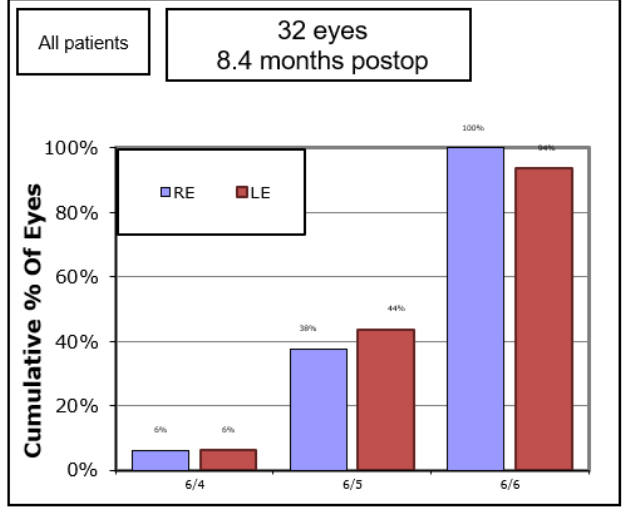
Figure 1. Percent of participants having a UCVA of at least 6/6, 6/5, and 6/4. Comparison between subgroups PRK (N = 13) and transepithelial-PRK (N = 3) of the refractive results showed that postoperative UDVA of 6/6 or better was obtained in 96% and 100% of the eyes, respectively ( p = 0.24) (Figure